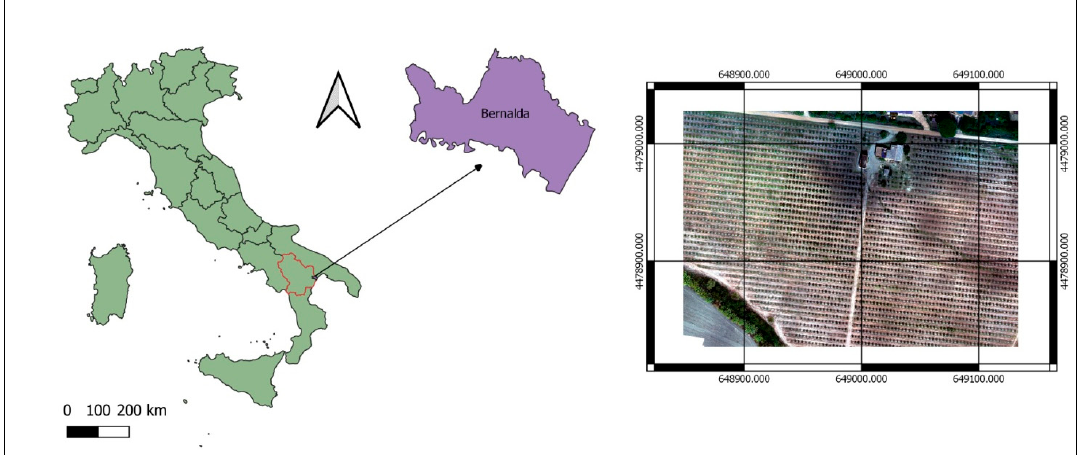
Figure 1. Left : geographical location of the farm, located in southern Italy; right : aerial photo of the research field taken from UAV with 6.29 cm/pixel.